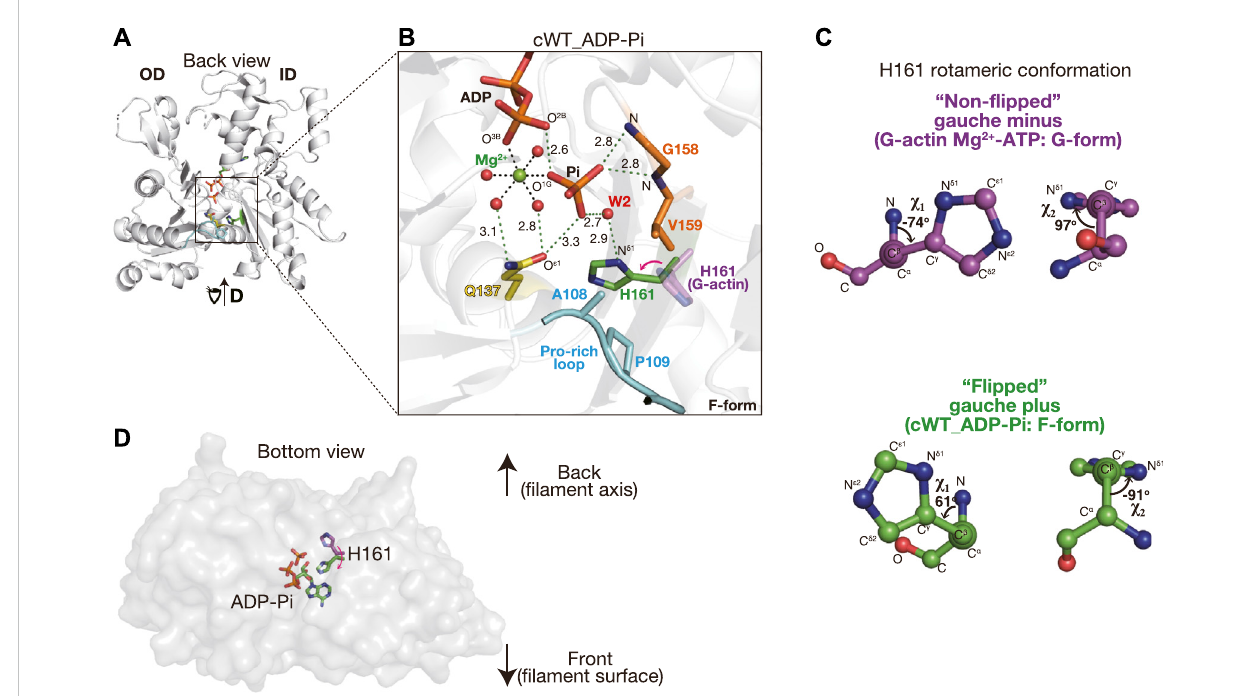
FIGURE 1 Structure of cWT_ADP-P i . (A) Structure of cWT_ADP-P i . The actin molecule in the crystal structure of the F1 and cWT ADP-P i complex is viewed from the back side with respect to the classical presentation by Kabsch et al. (1990). The overall complex structure including the fragmin F1 domain is shown in Supplementary Figure S2A. Three residues mutated in this study (Ala108, Pro109, and Gln137), and His161 are indicated by colored sticks. Pro- rich loop (residues 108 – 112) is highlighted in cyan. Actin-bound nucleotide (ADP-P i ) is depicted as sticks. (B) Close-up of the active site. In addition to the residues and nucleotide shown in (A) , Mg 2+ (green), its coordinated water molecules (red), and a helping water molecule W2 (red) are shown as spheres.Gly158andVal159hydrogenbondedwithP i via themainnitrogenchainareshowninorangesticks.Keyhydrogenbondsareindicatedbydashed green lines with distance (Å). The distances between Mg 2+ and the coordinated atoms (dashed black lines without digits) are 2.0 – 2.1 Å. His161 from a G-actin structure (4B1Y, magenta) is added to highlight the side-chain fl ipping associated with the G- to F-form transition. The red arrow shows the correspondence between two states and is not the rotational direction of the fl ipping. It should be noted that the actin conformation is indicated in the lowerrightcornerofeachpanel. (C) RotamericconformationofH161.The χ 1 and χ 2 anglesofHis161inG-formandF-formactinsarerepresentedbyball- and-stick models. (D) His161 fl ipping is viewed from the bottom of the actin